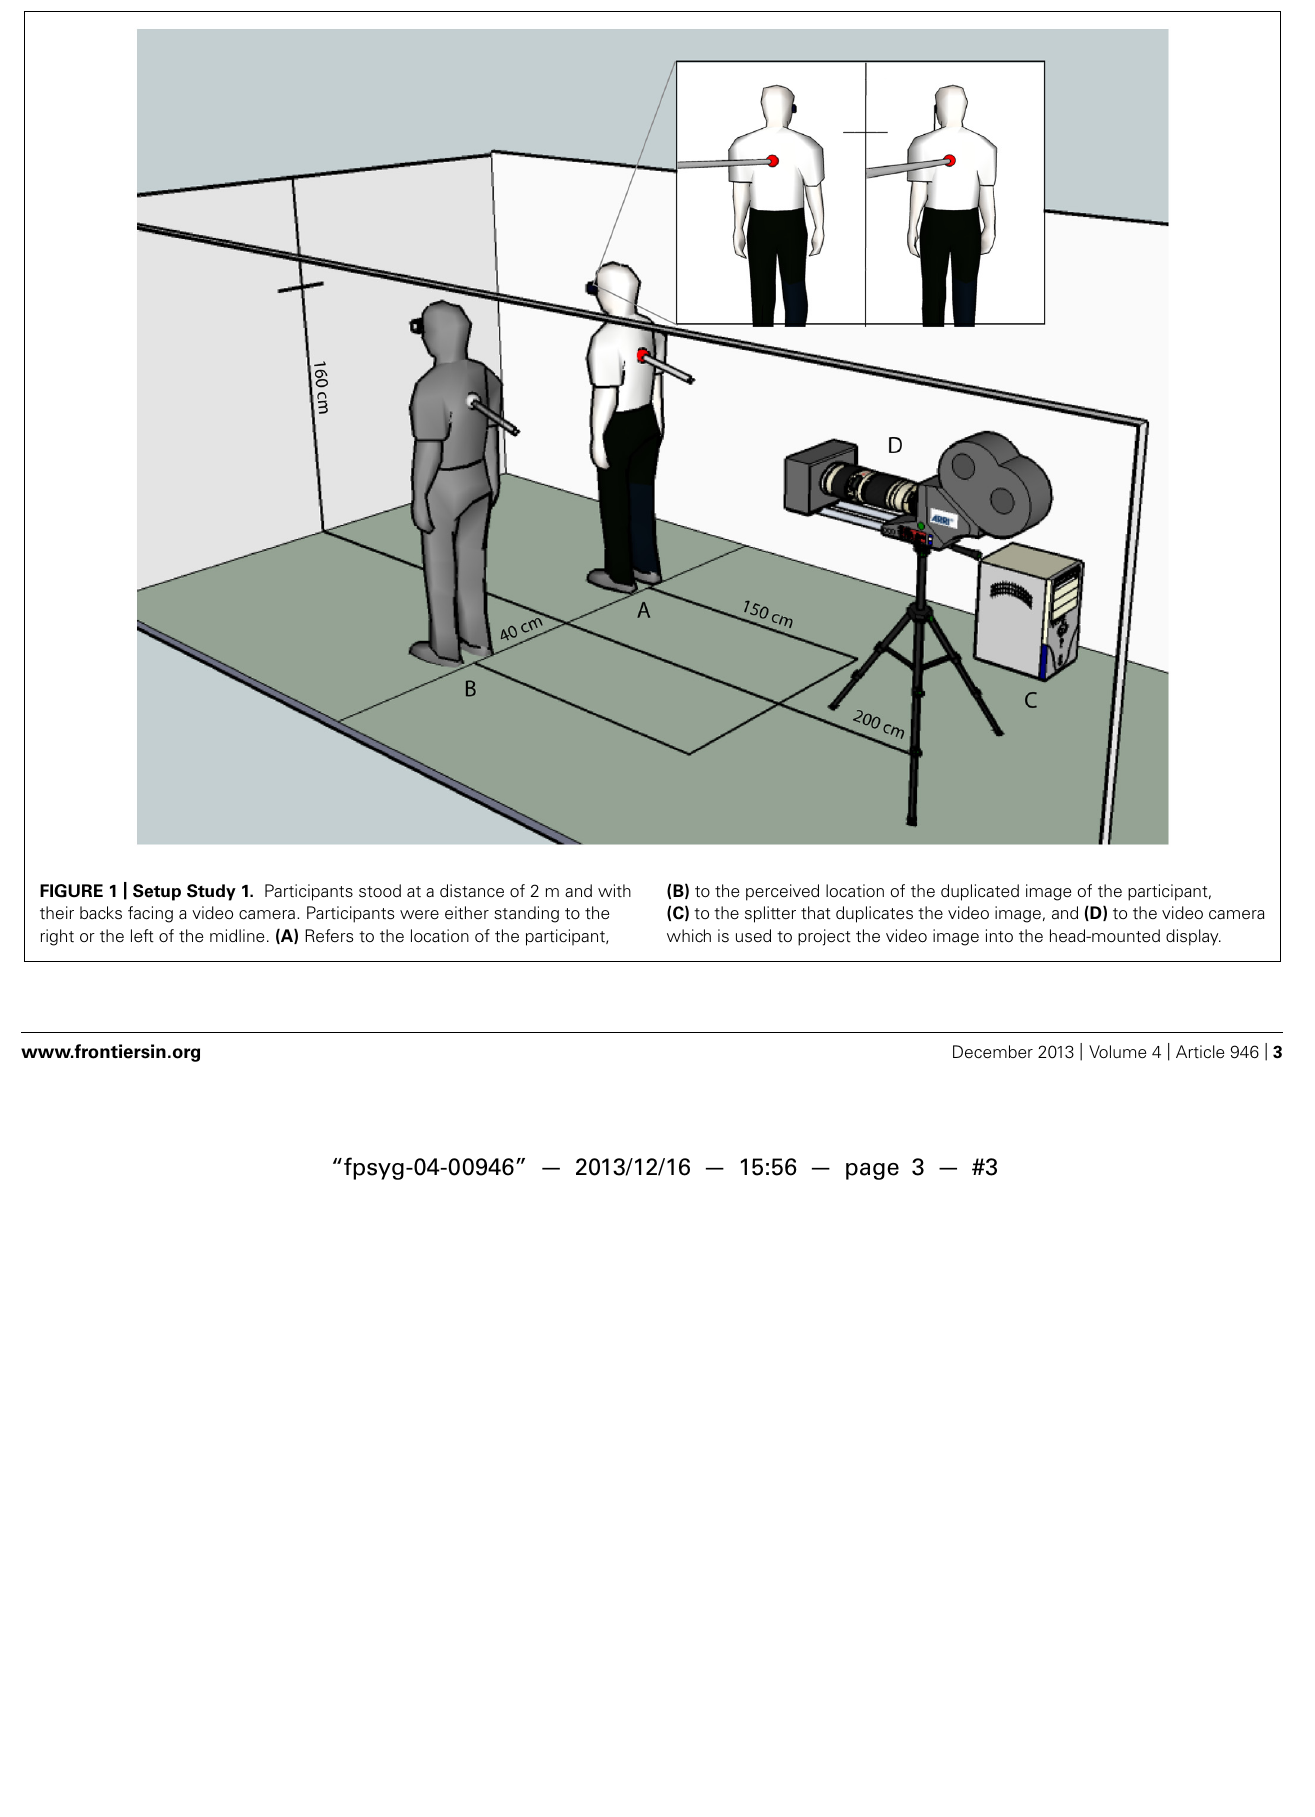
(B) to the perceived location of the duplicated image of the participant, (C) to the splitter that duplicates the video image, and (D) to the video camera which is used to project the video image into the head-mounted